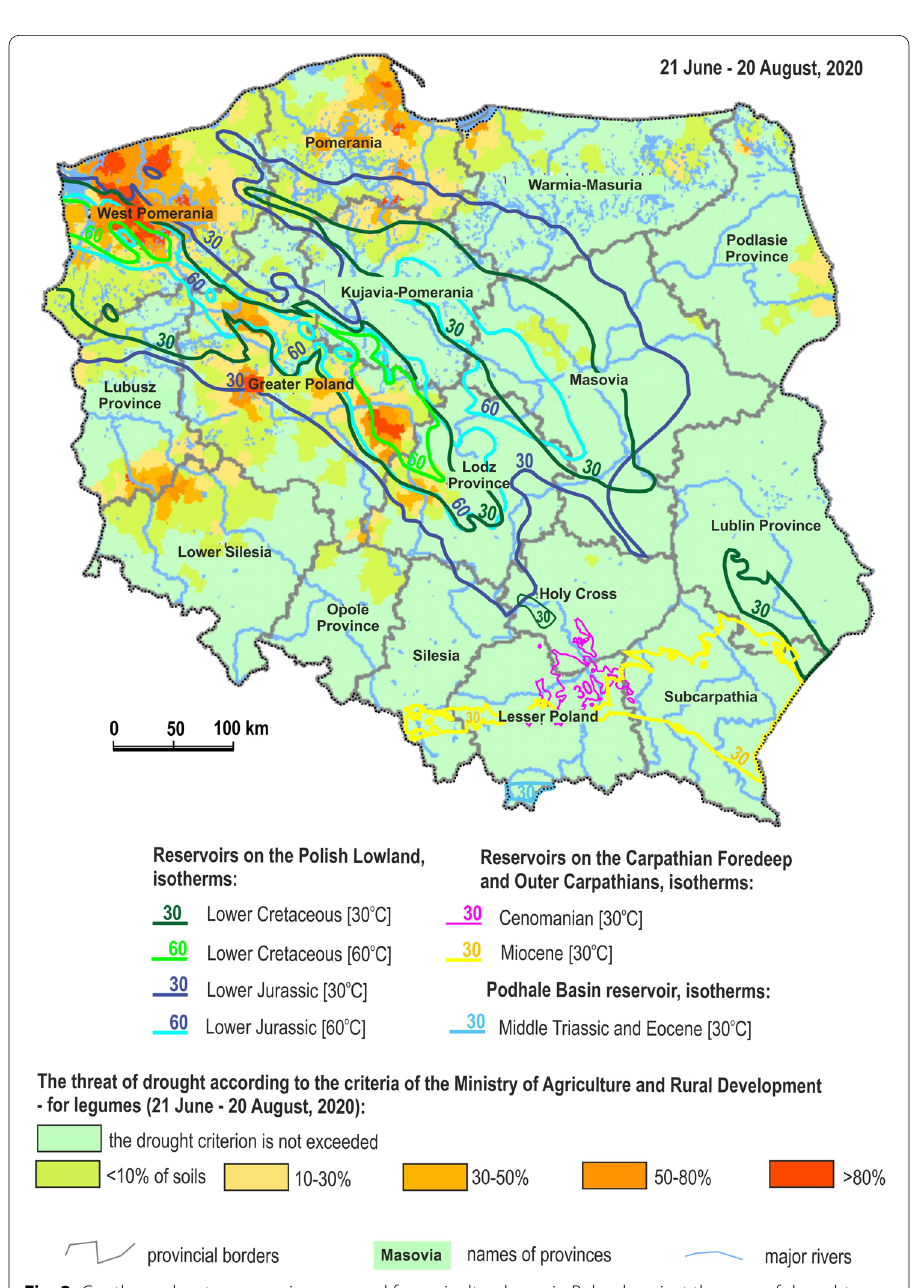
Fig. 3 Geothermal water reservoirs proposed for agricultural uses in Poland against the map of drought threats. Scientific description based on Barbacki et al. (2016); ranges of reservoirs with temperatures > 30 °C and > 60 ◦ C according to maps by Górecki et al. (2006, 2011, 2012, 2013); Map of drought threats according